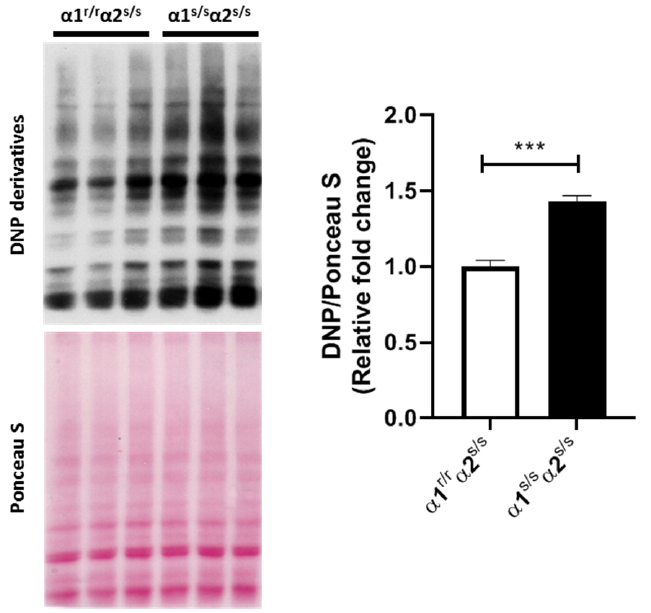
Figure 5. Increased protein carbonylation in α 1 s/s α 2 s/s hearts: Representative Western blot analysis